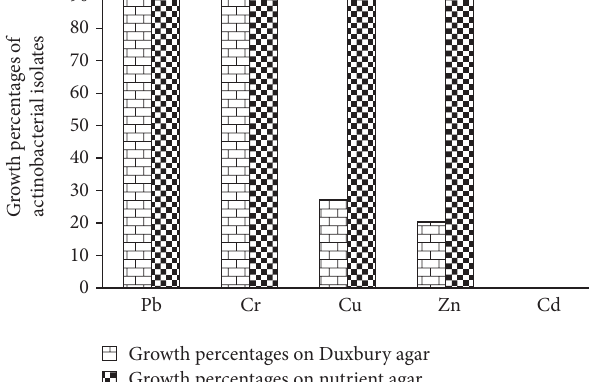
Figure 2: Growth percentages of actinobacterial isolates on both Duxbury agar and nutrient agar with: Pb, Cu, Zn, Cd, and Cr at the concentration 0.05 mg ⋅ mL −1 (the percentage of growth was calculated compared to the